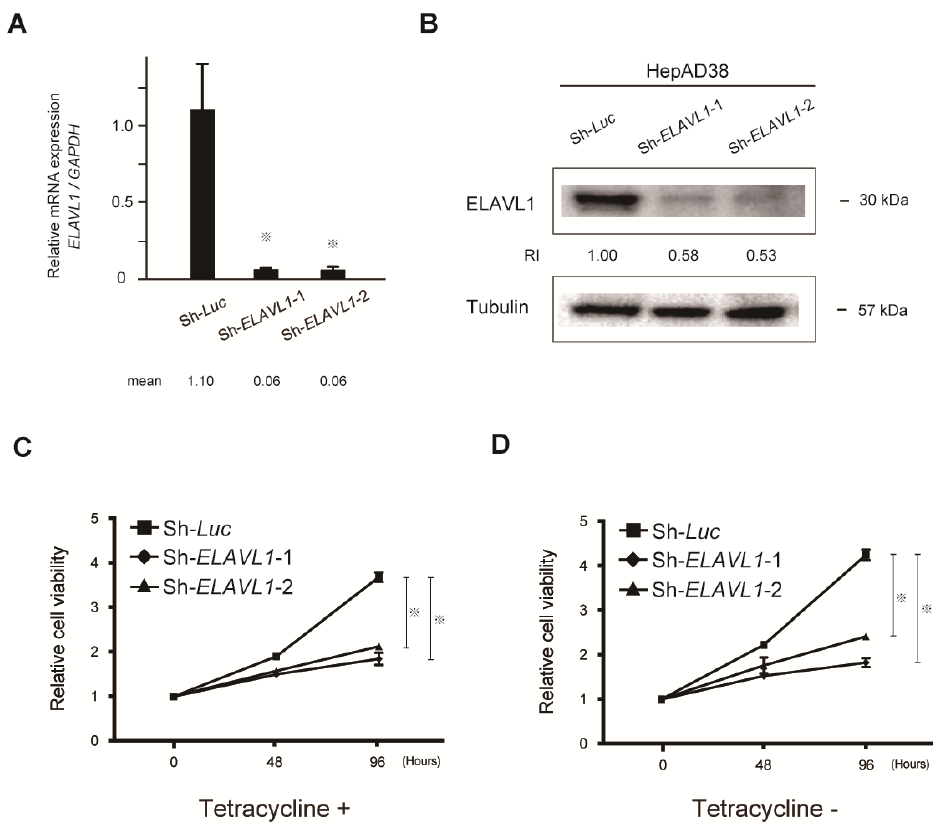
Figure 3. Cell growth inhibition in ELAVL1 -knockdown HepAD38 cells. ( A ) ELAVL1 -knockdown HepAD38 cells in the presence of tetracycline were subjected to quantitative real-time PCR analyses for ELAVL1 mRNA expression. Data represent the mean with SD of triplicate experiments (Student’s t -test, ※ p < 0.05). ( B ) HepAD38 cells with stable knockdown of ELAVL1 in the presence of tetracycline were subjected to Western blot analyses using anti-ELAVL1 and anti-tubulin antibody (loading control). RIs were determined by normalizing band intensities to those of internal controls. ( C ) Cell growth inhibition in ELAVL1 -knockdown HepAD38 cells in the presence of tetracycline. Data represent the mean with SD of triplicate experiments (Student’s t -test, ※ p < 0.05). ( D ) Cell growth inhibition in ELAVL1 -knockdown HepAD38 cells in the absence of tetracycline. Data represent the mean with SD of triplicate experiments (Student’s t -test, ※ p <